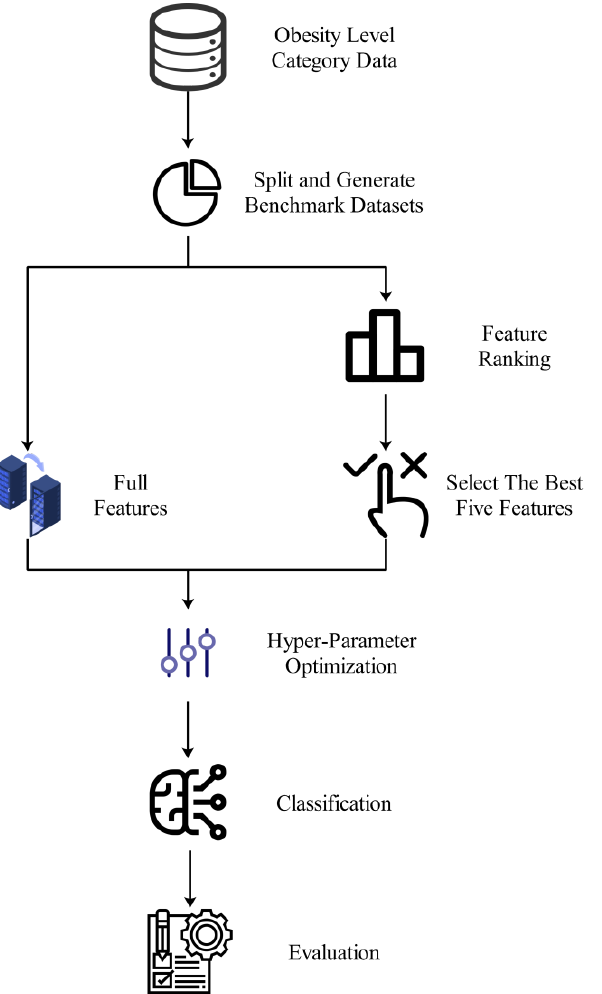
Figure 1. Demonstration of an end-to-end workflow diagram of the proposed system.